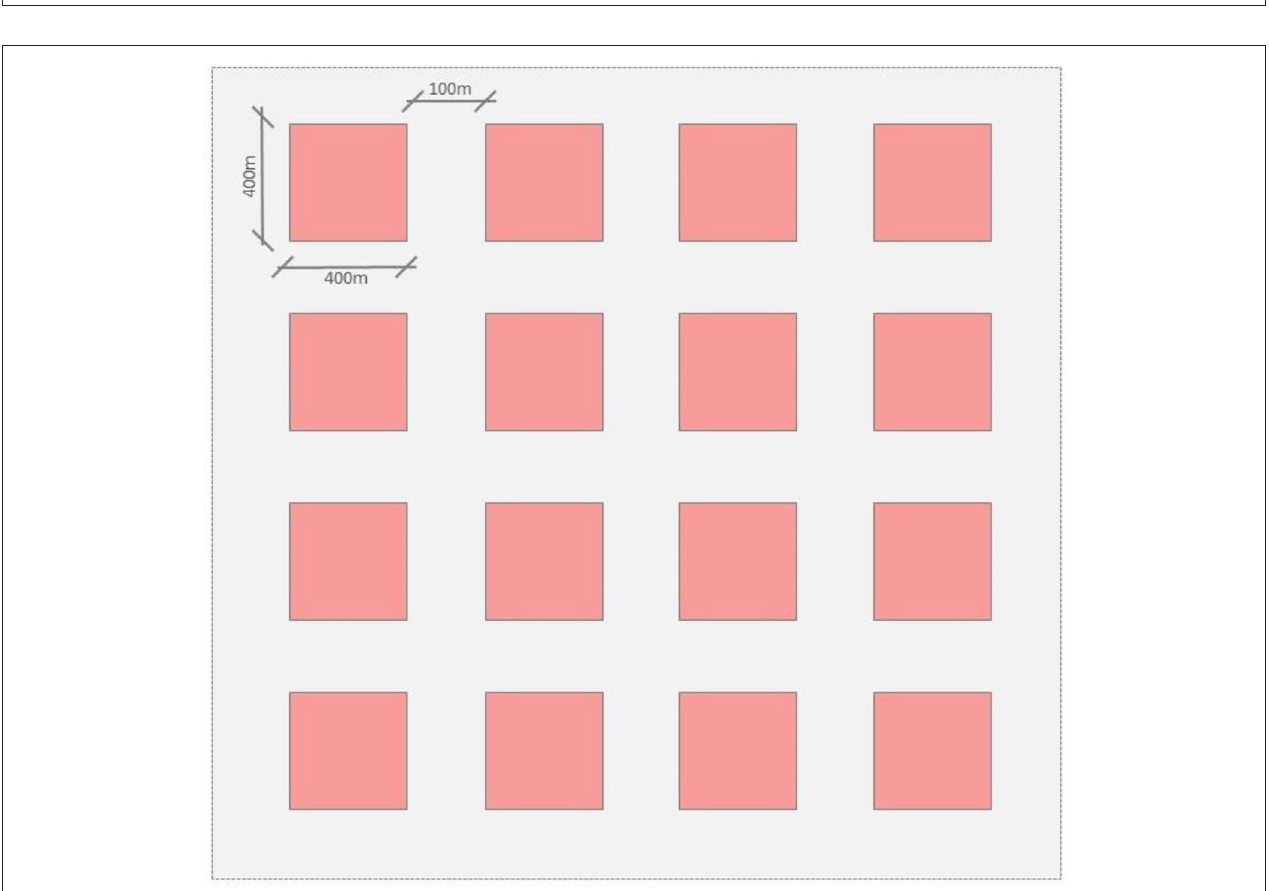
FIGURE 2 | Selected Manhattan Grid, with 400m × 400m blocks and 100m road network layout in between urban blocks (source: the authors).